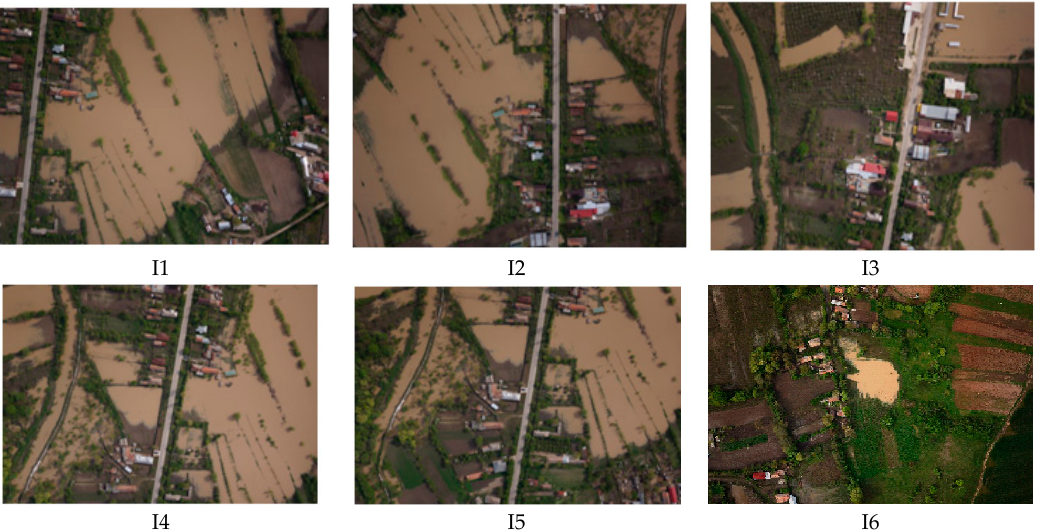
Figure 10. Images acquired by UAV MUROS to be evaluate for flood detection.